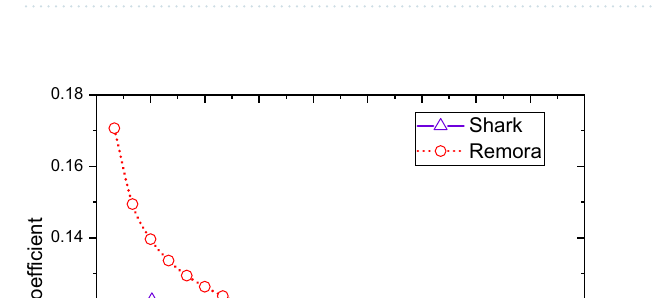
Table 2. The drag results of case 2 in various velocities.